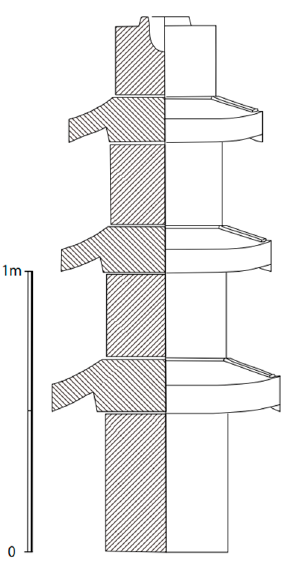
Figure 7. Drawing of Ry ū fukuji’s five-story pagoda (1/20 Sakurai and Fumihiko 1989).